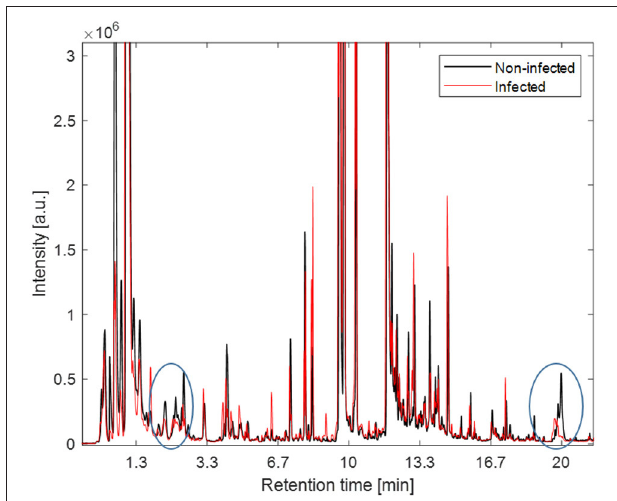
FIGURE 3 | The averaged VOCs profiles for pre-infection (black) and post-infection samples (red). The largest differences in averaged profiles is seen at retention time (RT, i.e., time after compounds captured in exhaled breath pass through a chromatographic column) 2min and 20 indicated by